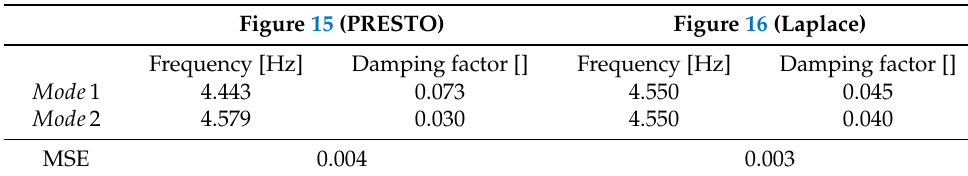
Table 4. Figures 15 and 16 estimated parameters.